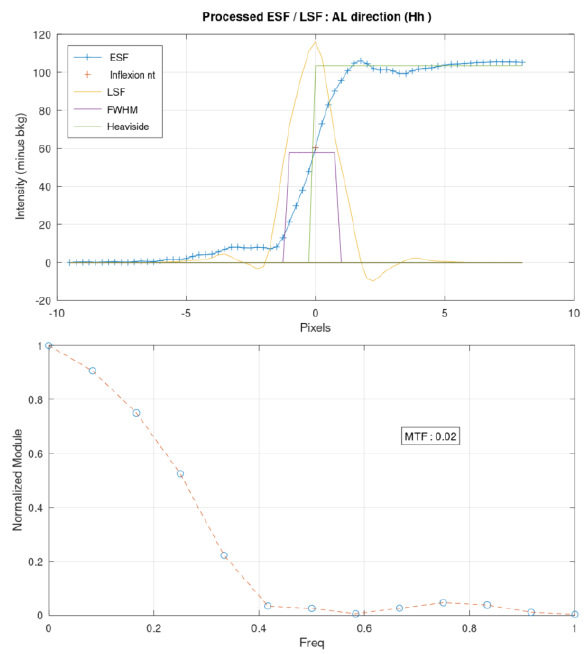
Figure 7. The ESF, LSF, FWHM, SNR, RER and MTF results from the green band HD obtained from the building in Munich.